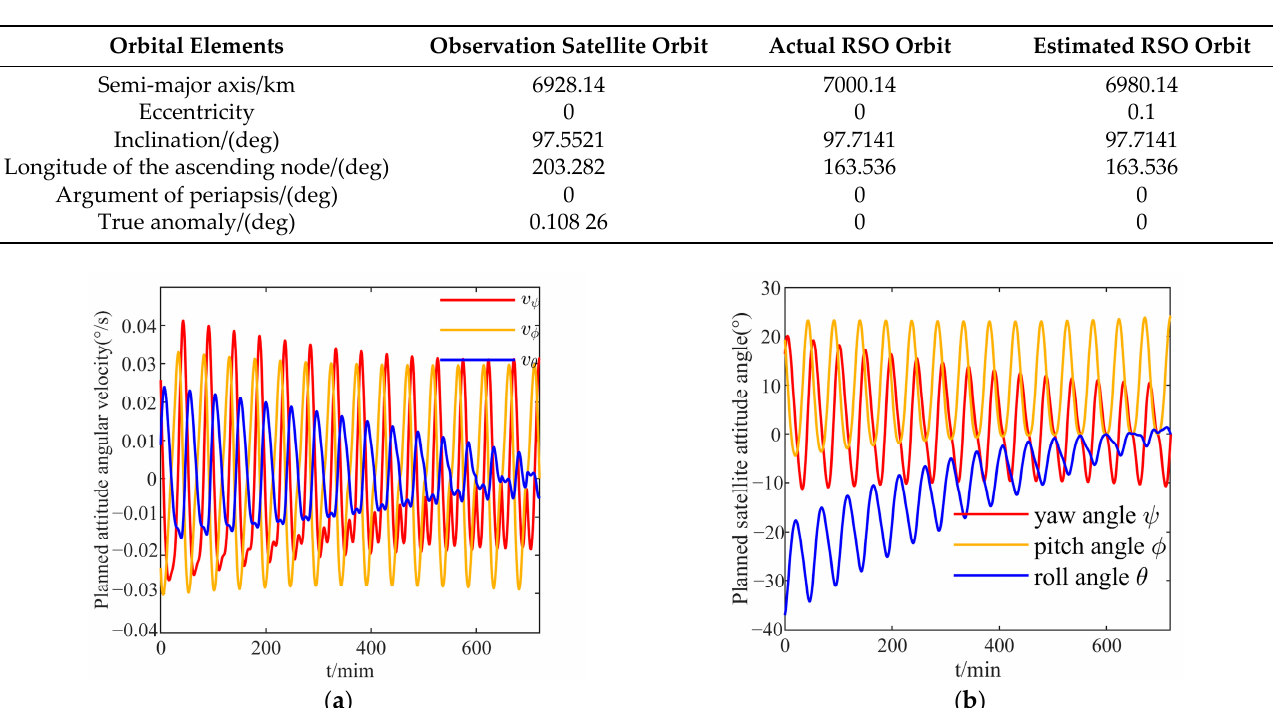
Figure 7. Planned satellite attitude angle and angular velocity: ( a ) three‑axis satellite attitude angle; and ( b ) three‑axis satellite angular velocity.